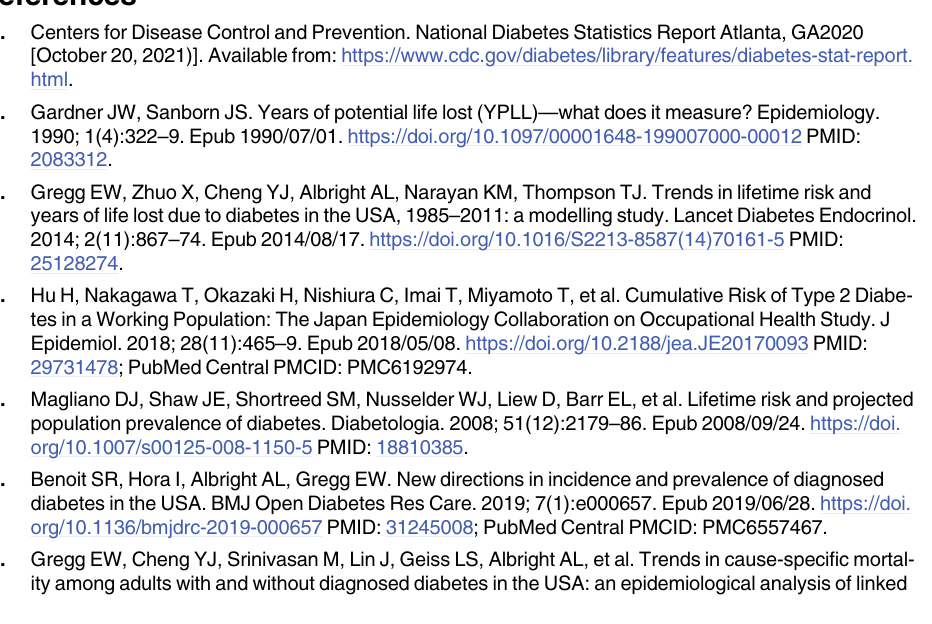
S1 Fig. Flow chart for study sample. S2 Fig. Formula used to derive lifetime